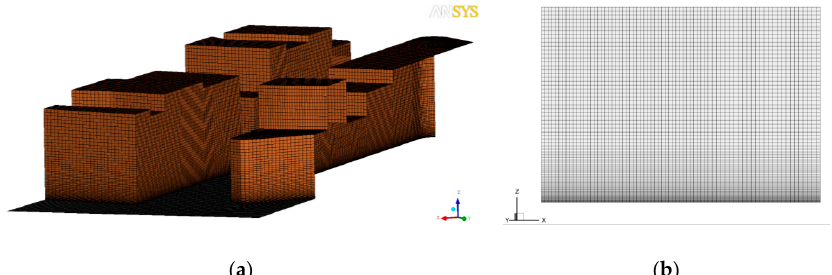
Figure 3. Detail of the grid used in the CFD model: ( a ) general view; ( b ) detail near the wall in a vertical section. Table 1. Grid information.